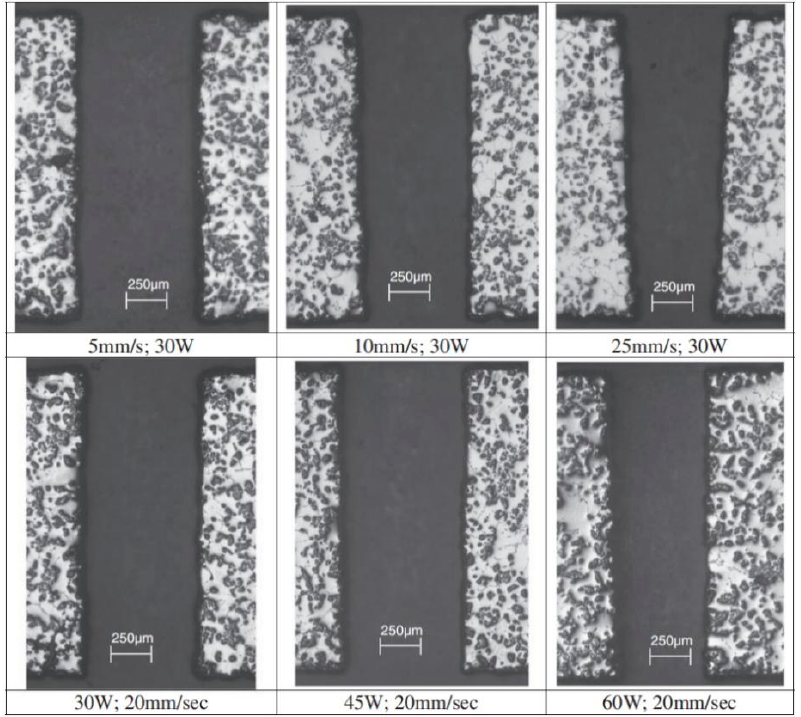
Figure 6. Microscopic image showing the hole cross-sections for various trepanning speeds and laser powers during water-guided laser drilling. Reprinted from [23], with permission from SAGE.